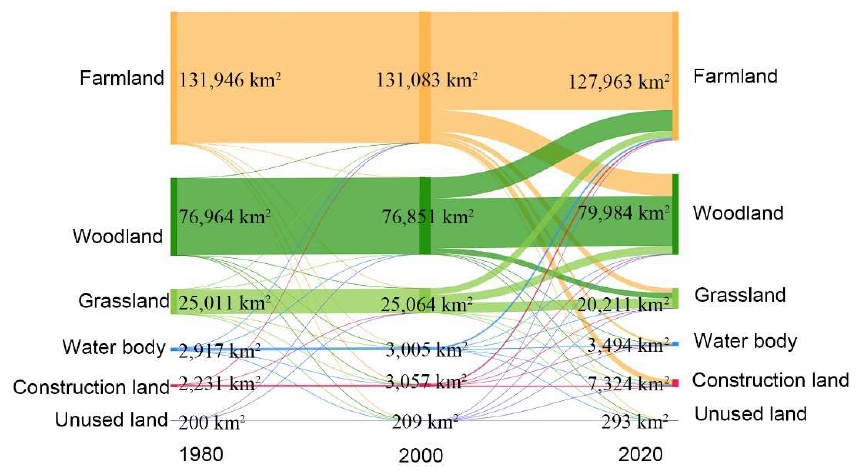
Figure 4. Results of the land-use transfer matrix analysis (from 1980 to 2000 and from 2000 to 2020).